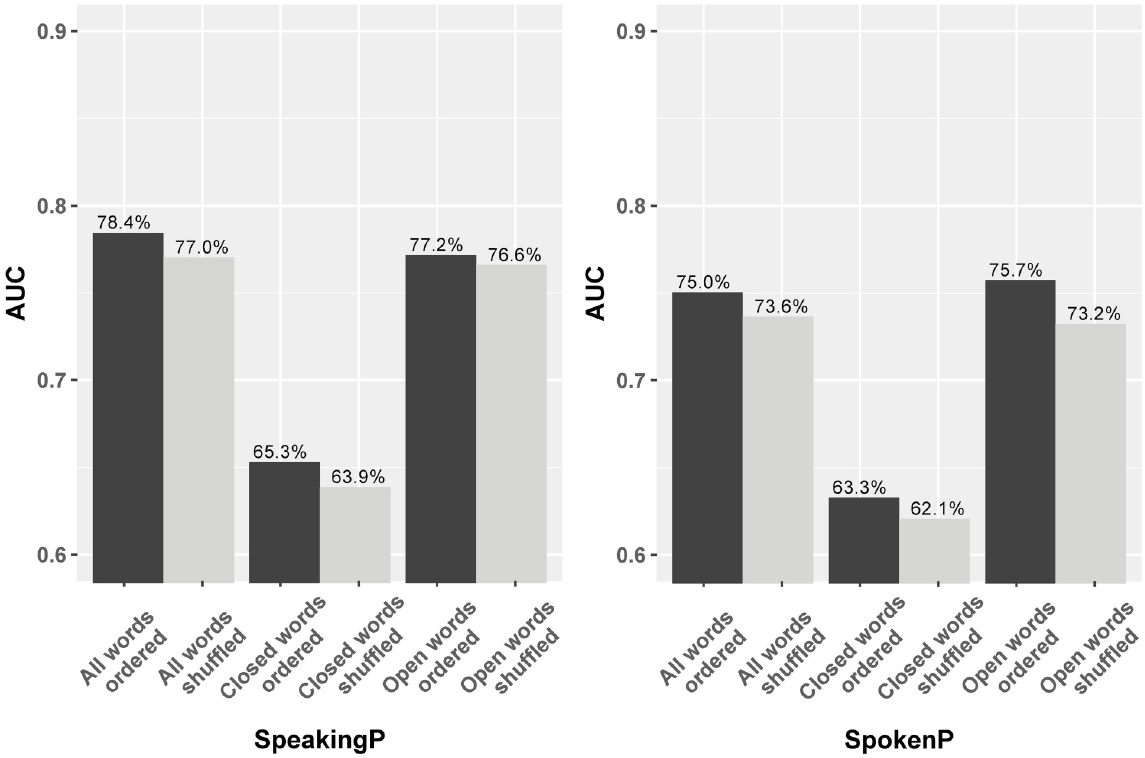
Fig 5. Barplot of AUC comparison for word categories and word ordering in the committer-only dataset.